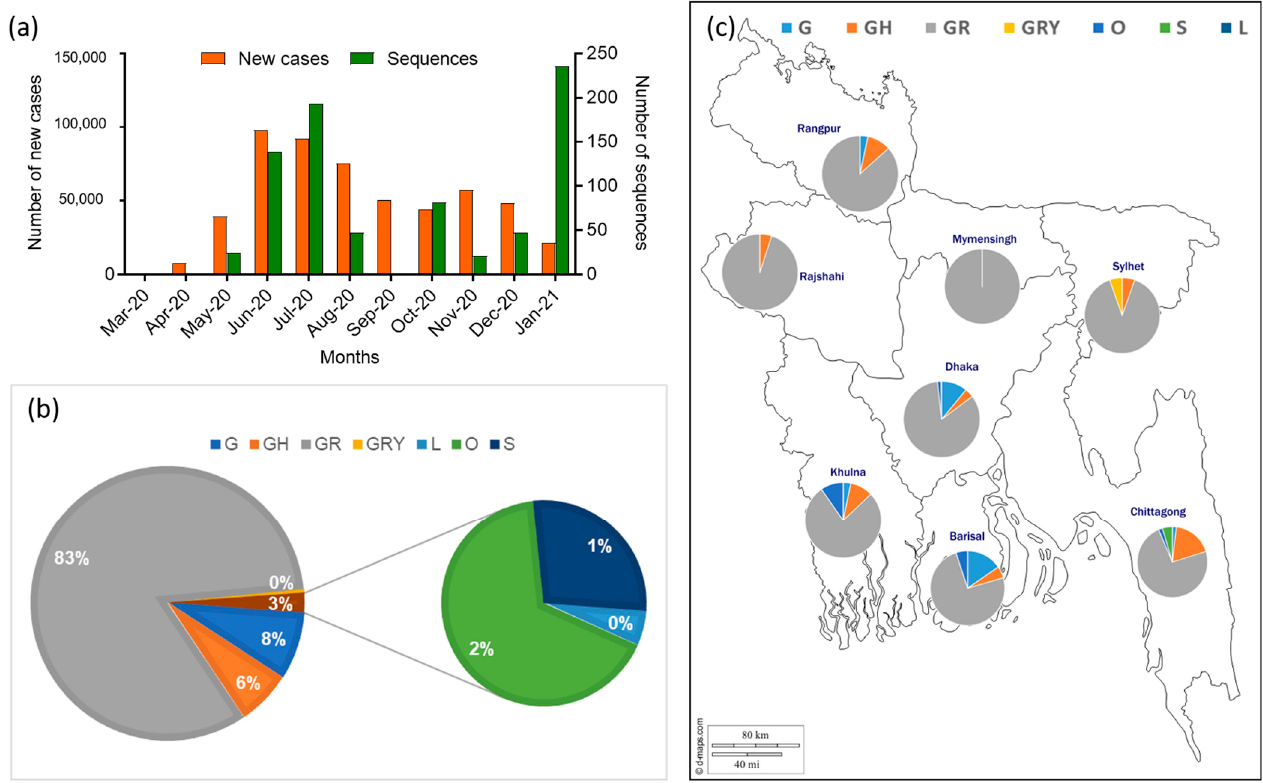
Figure 4. Distribution of SARS-CoV-2 genomes in Bangladesh. ( a ) The graph represents the number of sequences submitted in the GISAID database and the monthly confirmed new cases in Bangladesh. ( b ) The proportionate prevalence of the seven clades of SARS-CoV-2 detected in Bangladesh. ( c ) The proportionate distribution of seven clades of SARS-CoV-2 in eight administrative divisions of Bangladesh.